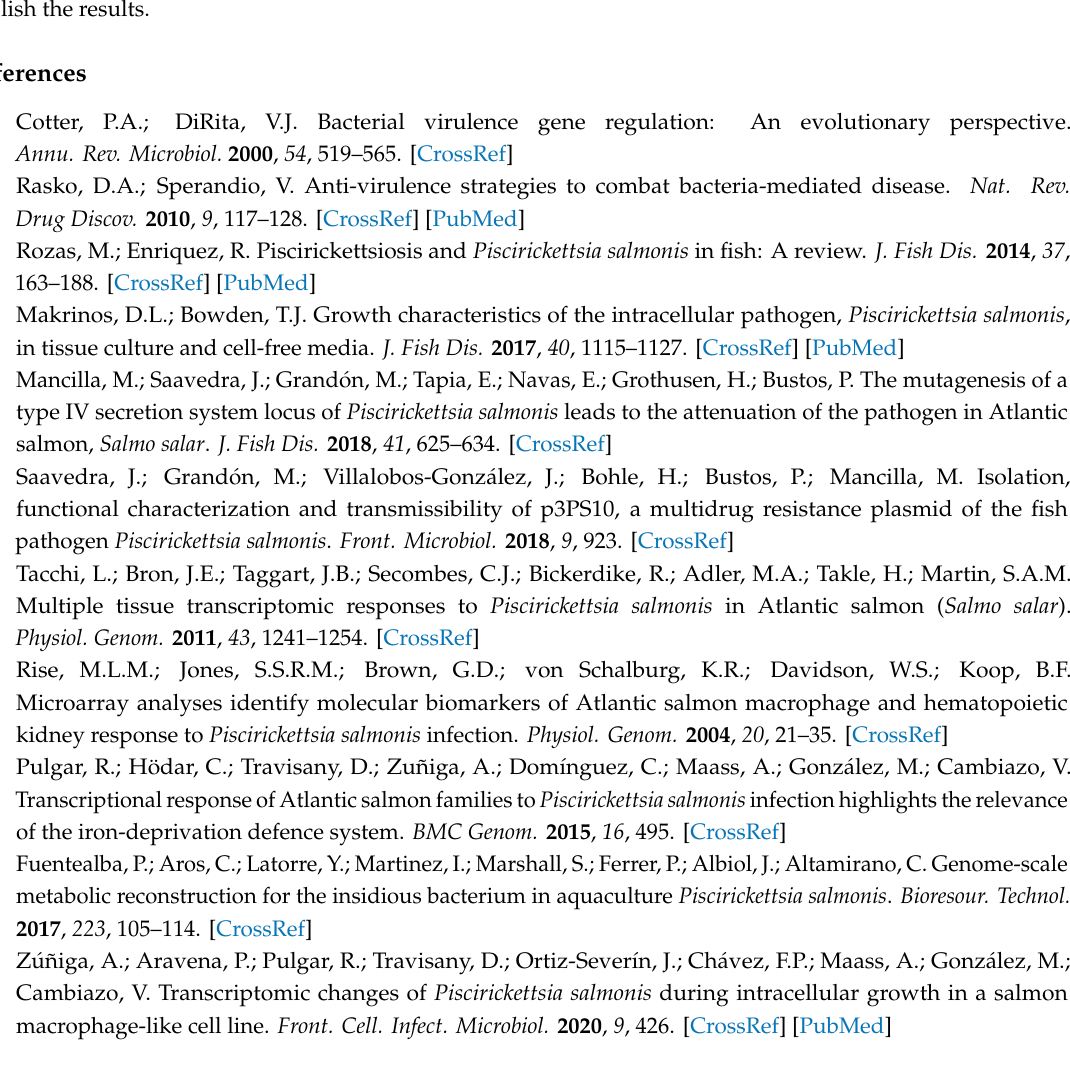
Figure S1: Schematic representation of sample pools obtained for global proteomic profiling of P. salmonis infections in SHK-1 cultures, Table S1: P. salmonis LF-89 and S. salar SHK-1 cells quantitative proteomics results, Table S2: Primers used for qPCR analyses, Table S3: Enrichment analyses of S. salar proteomic results, Table S4: qPCR analysis of P. salmonis selected virulence